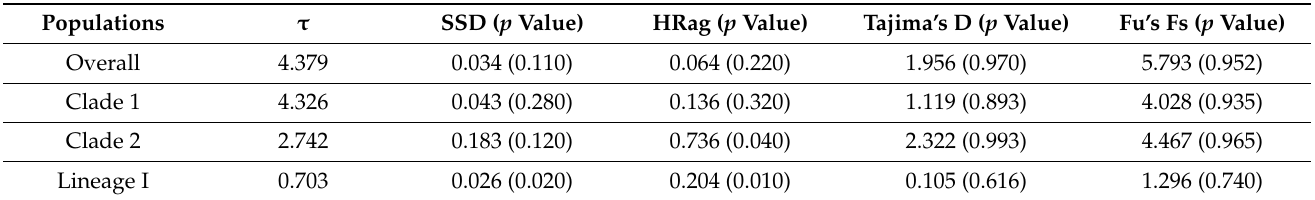
Figure 4. Mismatch distribution analysis for cpDNA data for all 28 populations ( A ), Clade 1 ( B ), Clade 2 ( C ), and Lineage I ( D ). Clade 2 ( C ), and Lineage I ( D ). Table 4. Results of neutrality tests and mismatch distribution analysis for Clade 1, Clade 2, Lineage I , and the overall populations based on